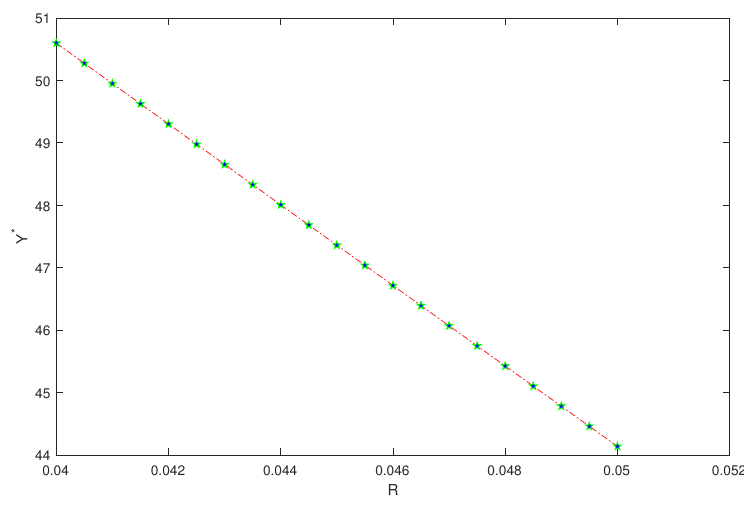
Figure 6. Influence of R on Y ∗